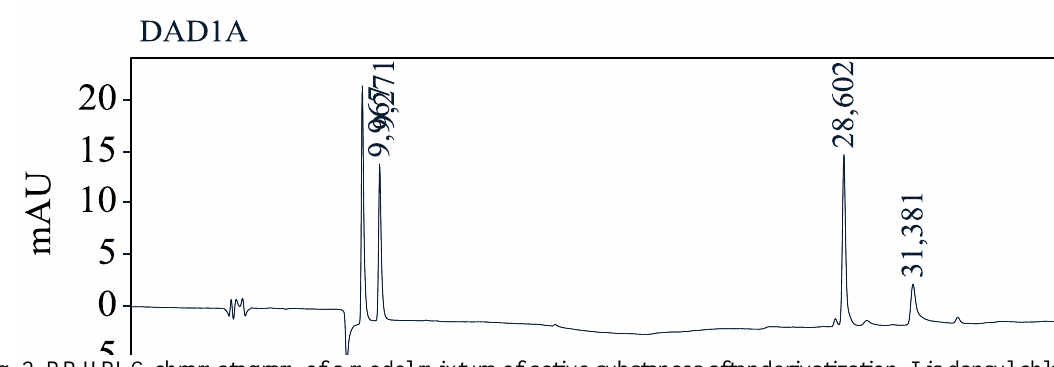
Fig. 2. RP HPLC chromatogram of a model mixture of active substances after derivatization. I is dansyl chloride (9.3 min); II is para-aminobenzoic acid (10.0 min); III is aminocaproic acid derivative (28.6 min). The analytical wave- length is 288